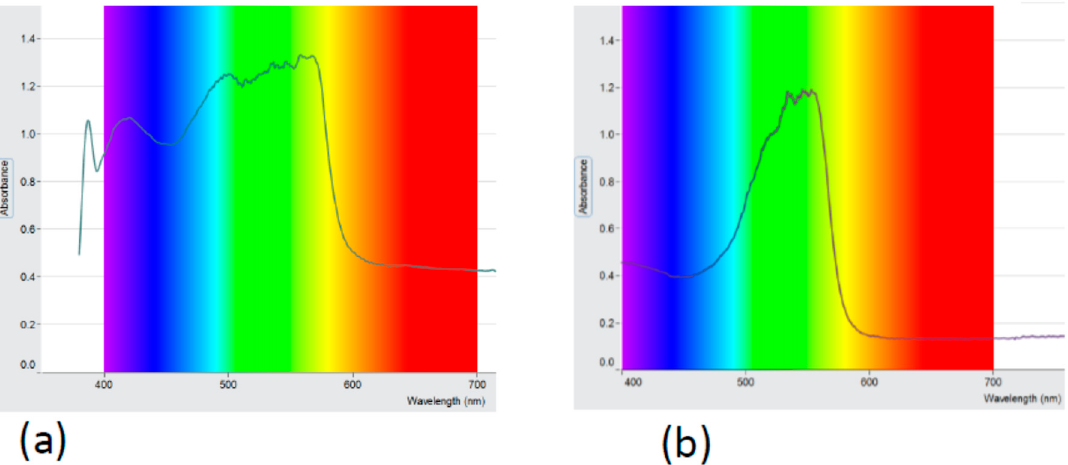
Figure 5. Absorbances of the 0.1 mM rhodamine B (RB) solution before decomposition by the cobalt-titanate particle-containing composite fiber ( a ) and after decomposition for 6 days under sunlight ( b